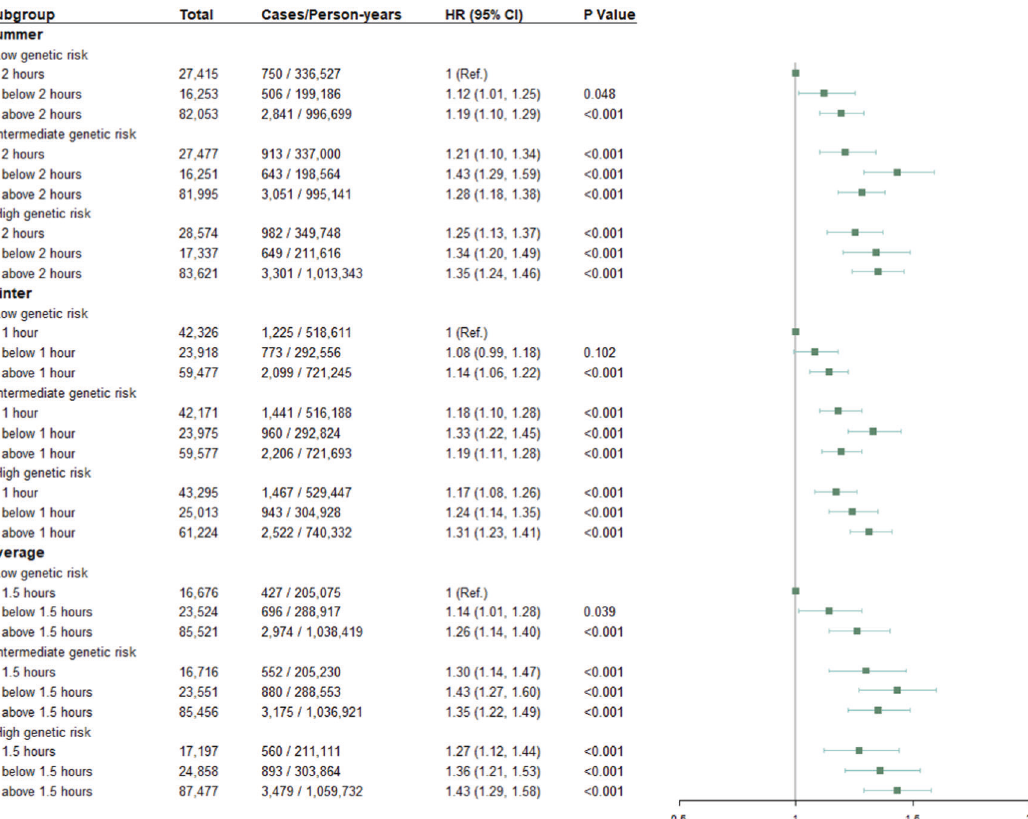
Fig. 2 Risk of incident depression according to genetic risk and time spent in outdoor light. HR hazard ratio, 95% CI 95% con fi dence interval. Adjusted for age, gender, education, Townsend deprivation index, smoking status, drinking status, body mass index, total physical activity, sleep duration, fracture history, vitamin D supplement, hearing loss, use of sun/UV protection, PM 2.5 , hypertension, and